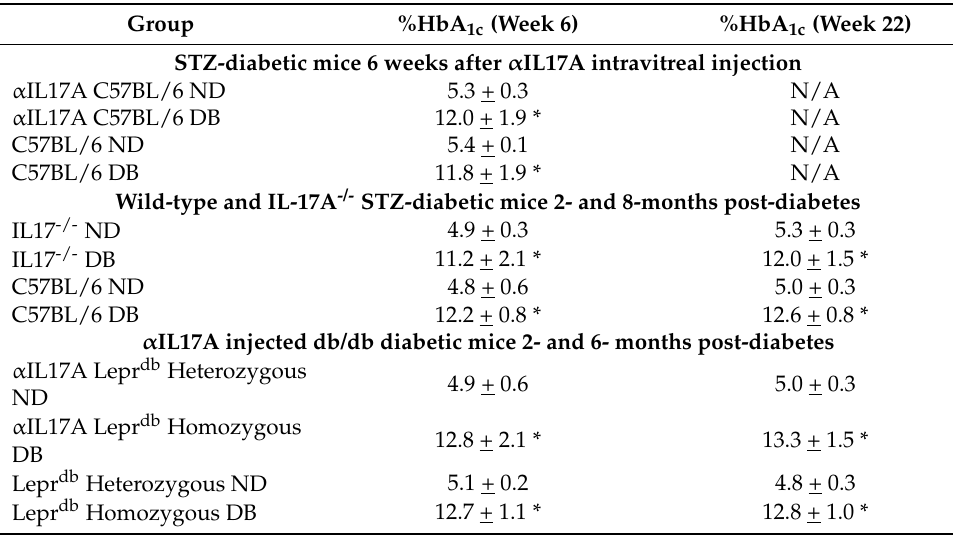
Table 1. Clinical data of non-diabetic and diabetic